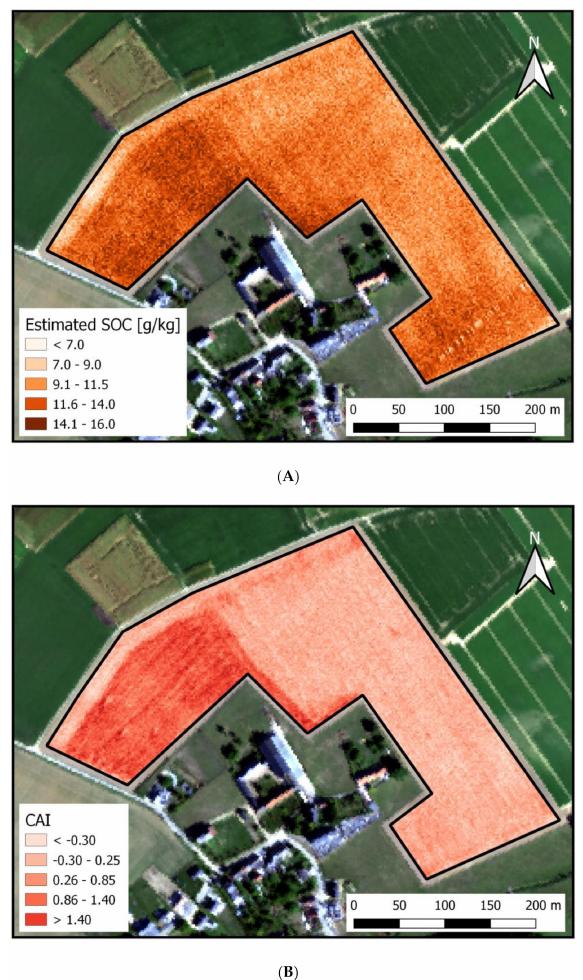
Figure 10. Comparison of the spatial patterns of ( A ) predicted SOC content by a Partial Least Squares Regression (PLSR) model on extracted airborne hyperspectral data and ( B ) the Cellulose Absorption Index (CAI) calculated from extracted airborne hyperspectral data in Geest field. For the location of the Geest field see Figure 1.